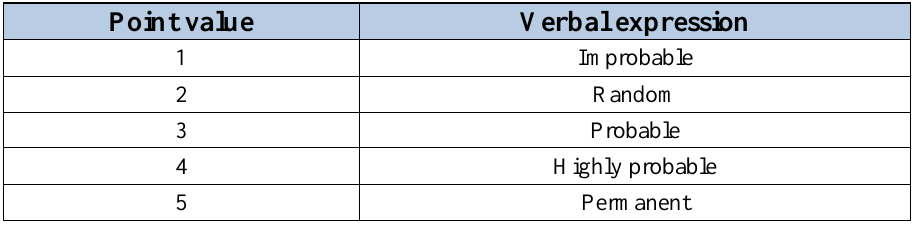
Table 2 Probability estimation